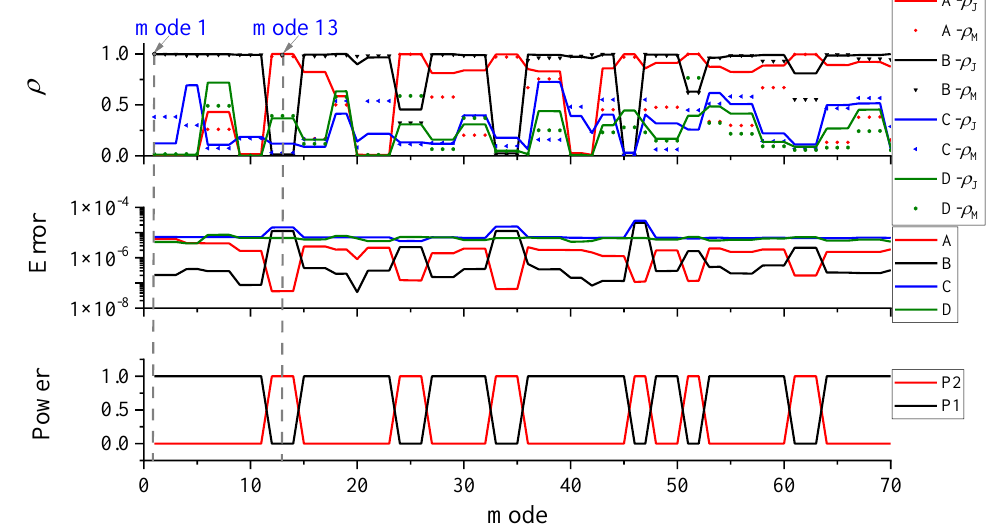
Figure 3. Boundary condition judgements of four problems for the first 70 lower-order modes by using correlation coefficient and error schemes. The resulting power is also plotted in the last graph.